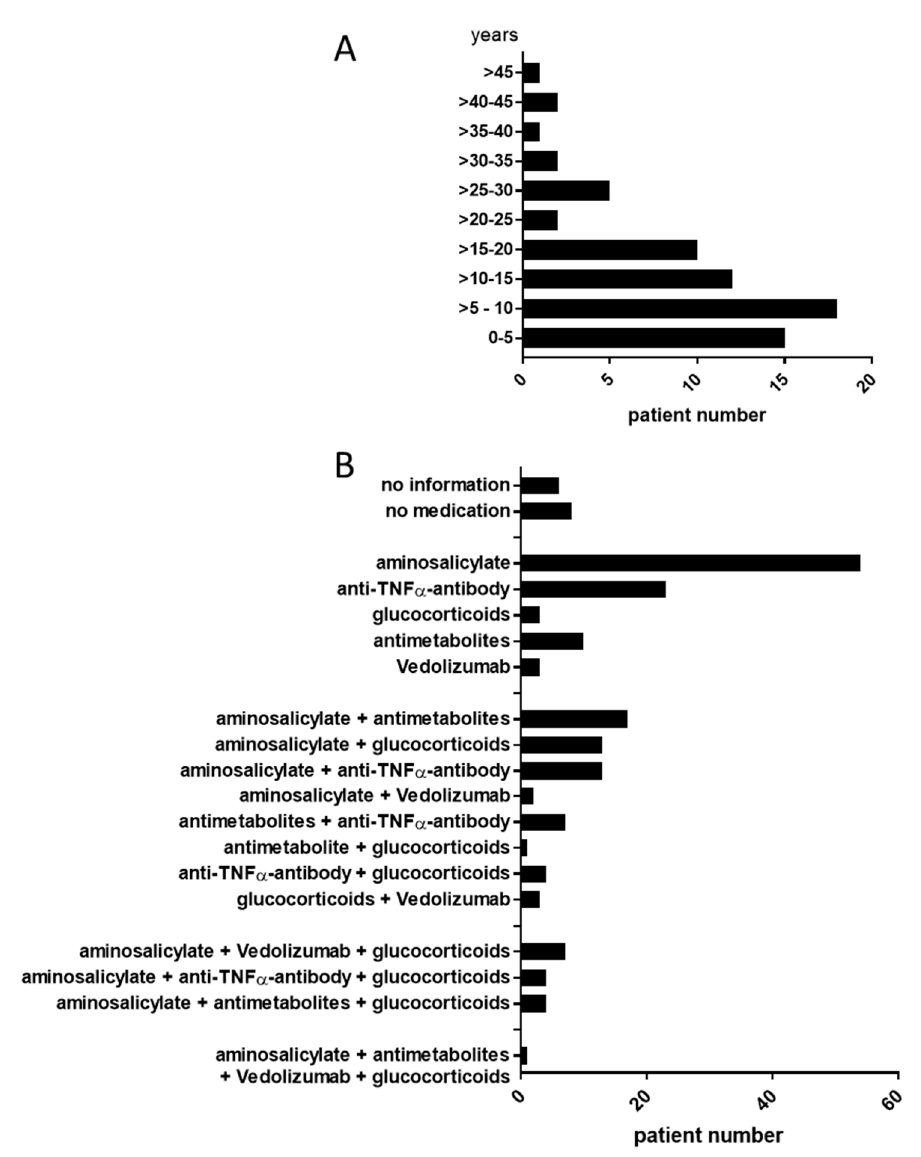
Figure 1. Patient data. ( A ) Time of disease duration in our ulcerative colitis (UC) patient cohort. ( B ) Overview of medical treatments of UC patients included in this study.